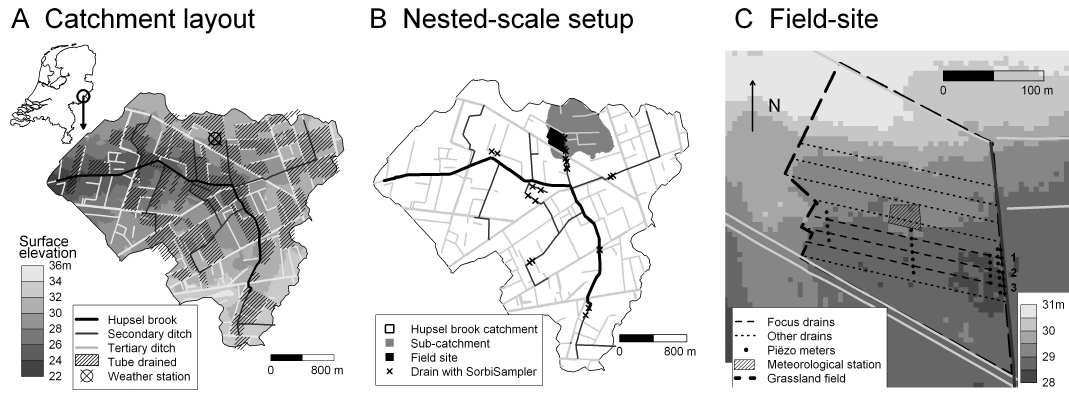
Fig. 1. Hupsel Brook catchment and nested-scale measurement